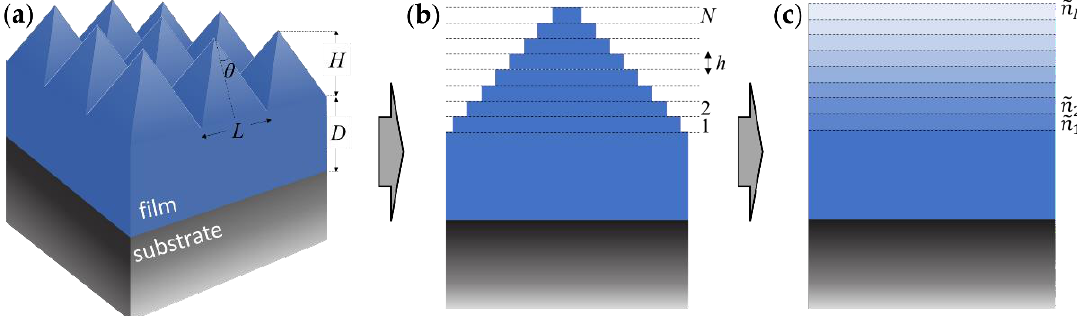
Figure 1. ( a ) Schematic of the system under study, where roughness is modelled as a periodic array of linear square-based pyramids. ( b ) Roughness is discretized in a series of slices. ( c ) Obtaining an effective medium for each slice, roughness becomes just a multi-layer film easily solved by a transfer matrix method.